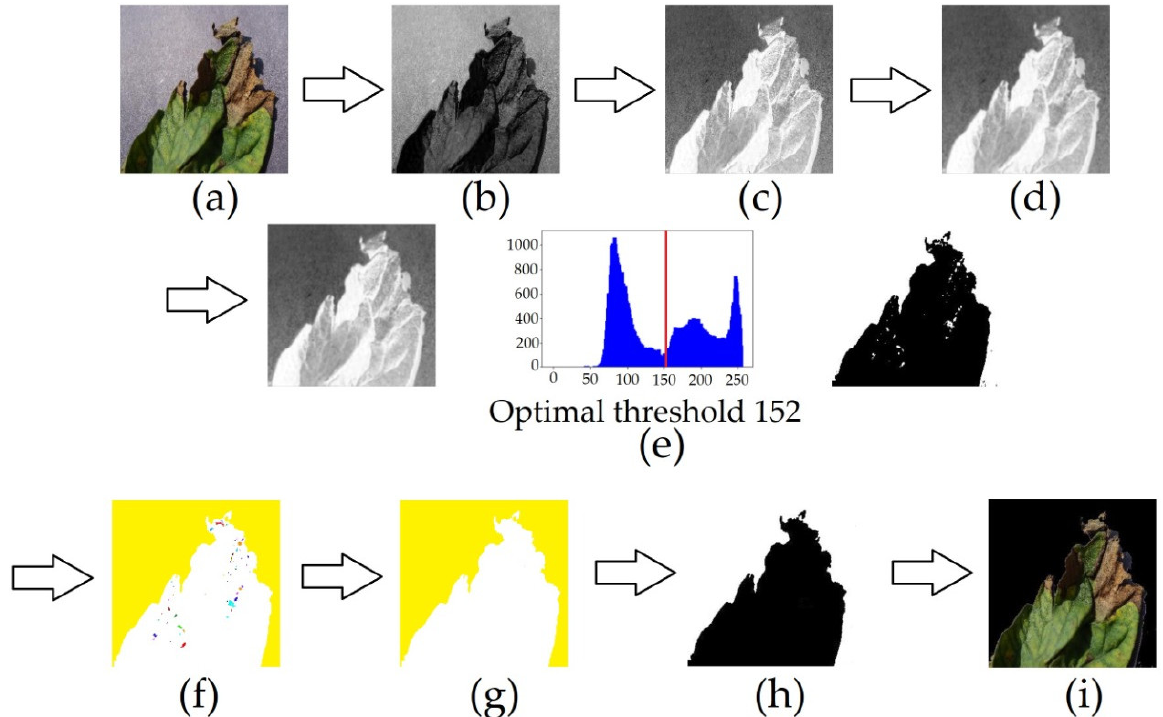
Figure 4. Segmentation of the sheet: in ( a ) original image, ( b ) gray scale, ( c ) negative, ( d ) median filter, ( e ) method of Otsu, ( f ) related components, ( g ) components removed, ( h ) binarized segmented sheet and ( i ) segmented color sheet.